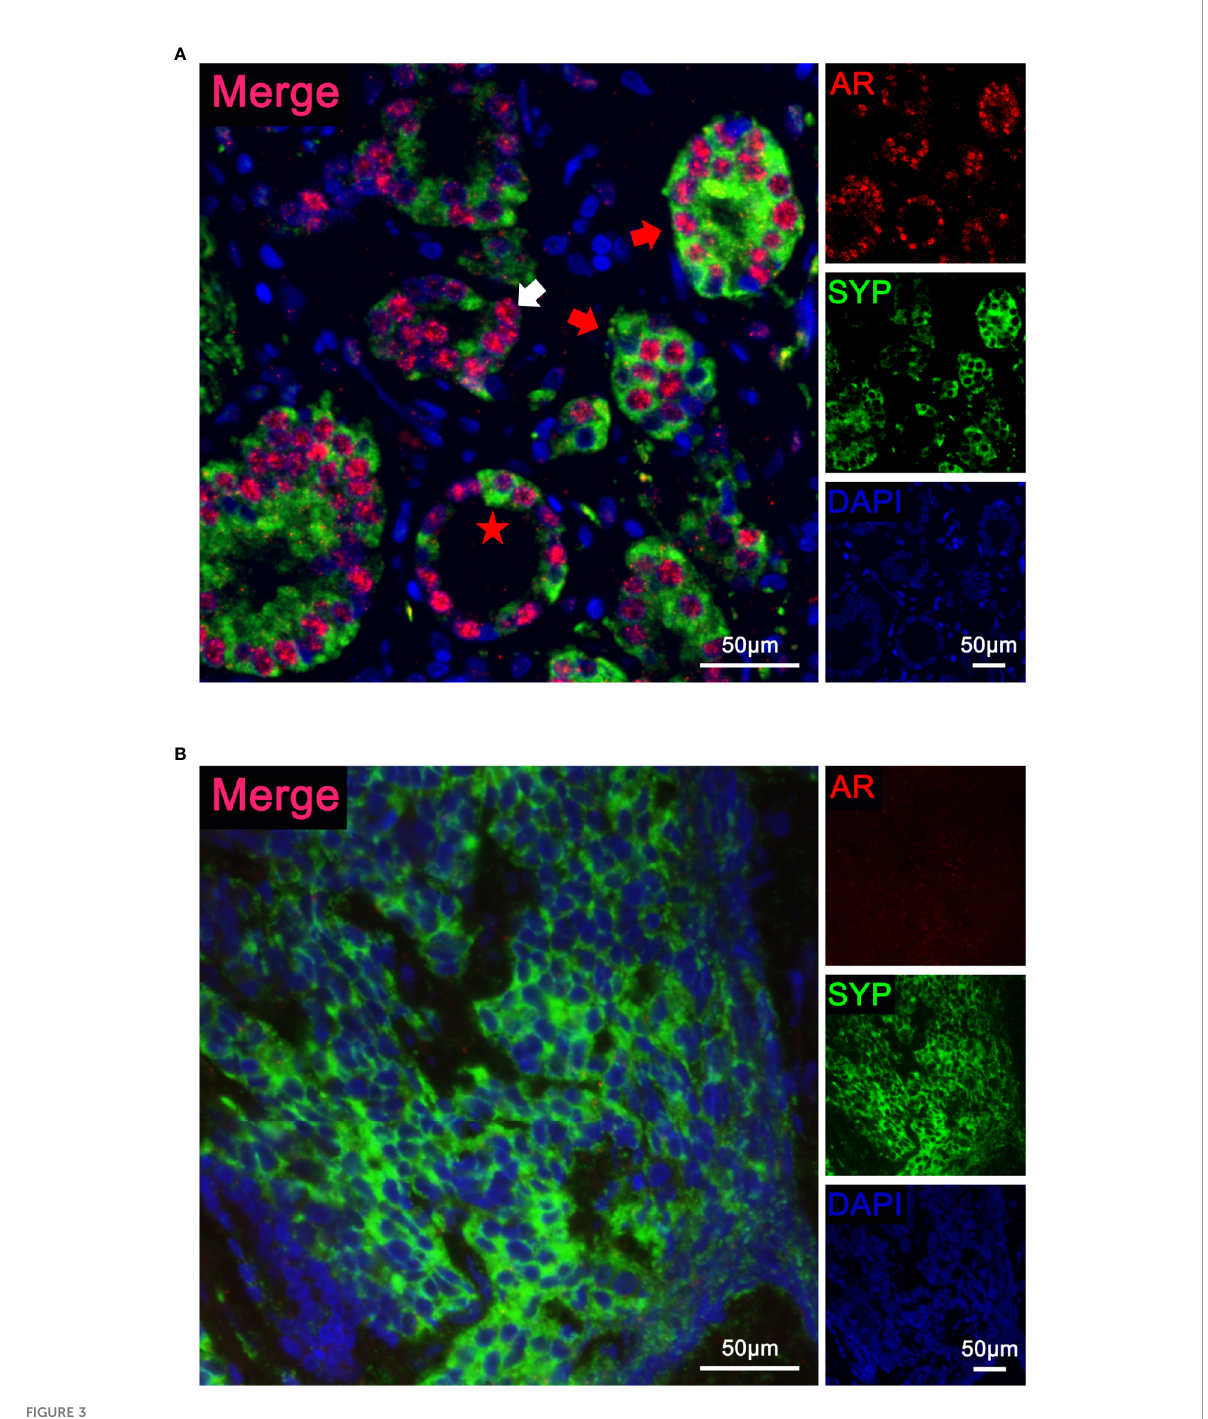
FIGURE 3 Localization of androgen receptor (AR) and synaptophysin (SYP) in prostate cancer with neuroendocrine differentiation. (A) Representative immuno fl uorescence images of a hormone-naïve AR+ case with Gleason Score 7 simultaneously stained with a three-color multiplex panel containing DAPI (blue), AR (red), and SYP (green). The white arrowhead indicates malignant tumor tissue with AR expression only. The red arrowheads indicate malignant tumor tissue with both AR and SYP expression. The red star indicates an AR and SYP double-positive cell in adjacent premalignant prostate lesion. (B) Representative immuno fl uorescence images of a hormone-naïve AR- case with non-applicable Gleason Score simultaneously stained with a three-color multiplex panel containing DAPI (blue), AR (red), and SYP (green). The tumor cells presented small cell morphology with high malignancy and showed positive